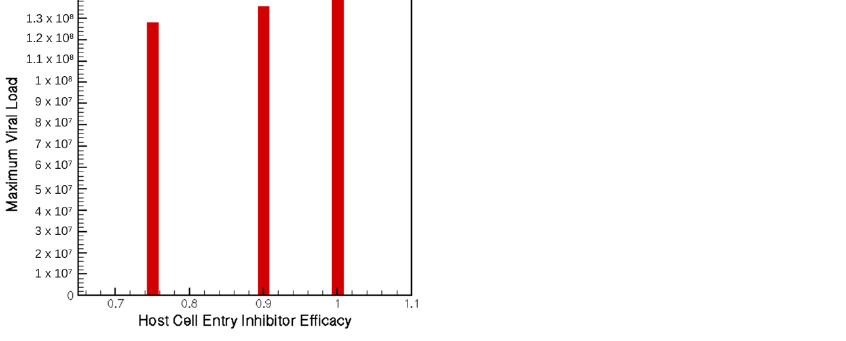
Figure 4. Maximum viral load for three potential levels of host-cell entry inhibition